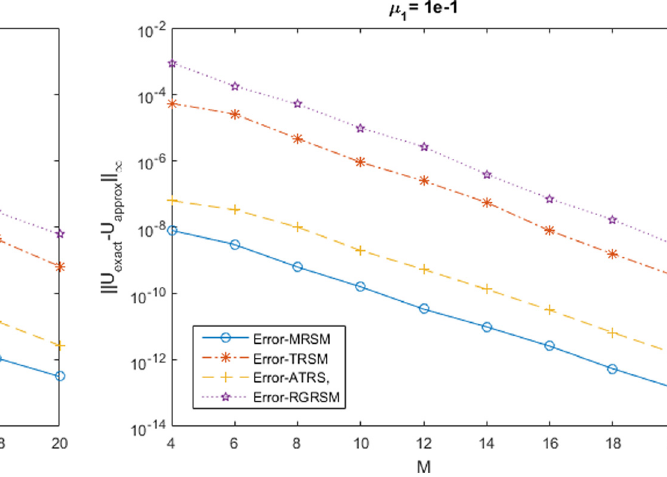
Figure 3: The absolute error of Example 4.1 by RSMs with t 0, 1 ( ] ∈ and M 4, 6,…, 20 = , and r −1, 1 ( ) ∈ and N 4, 6,…, 20 = at μ 0.1 with α 1 = and β 1 = .